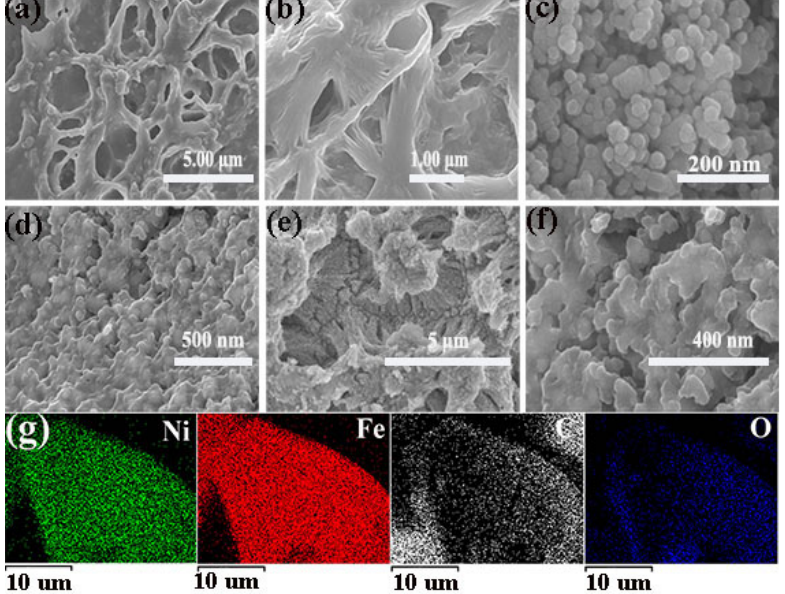
Figure 2. HR − SEM of ( a ) cellulose aerogels; ( b ) cellulose carbon aerogels; ( c ) NiFe 2 O 4 nanoparticles; ( d – f ) cellulose/50%NiFe 2 O 4 − CA − 600 °C; ( g ) EDS − mapping image of co tt on linter cellu- ( d – f ) cellulose/50%NiFe 2 O 4 -CA-600 ◦ C; ( g ) EDS-mapping image of cotton linter cellulose/NiFe2O4- lose/NiFe2O4 − CA − 600 °C. CA-600 ◦